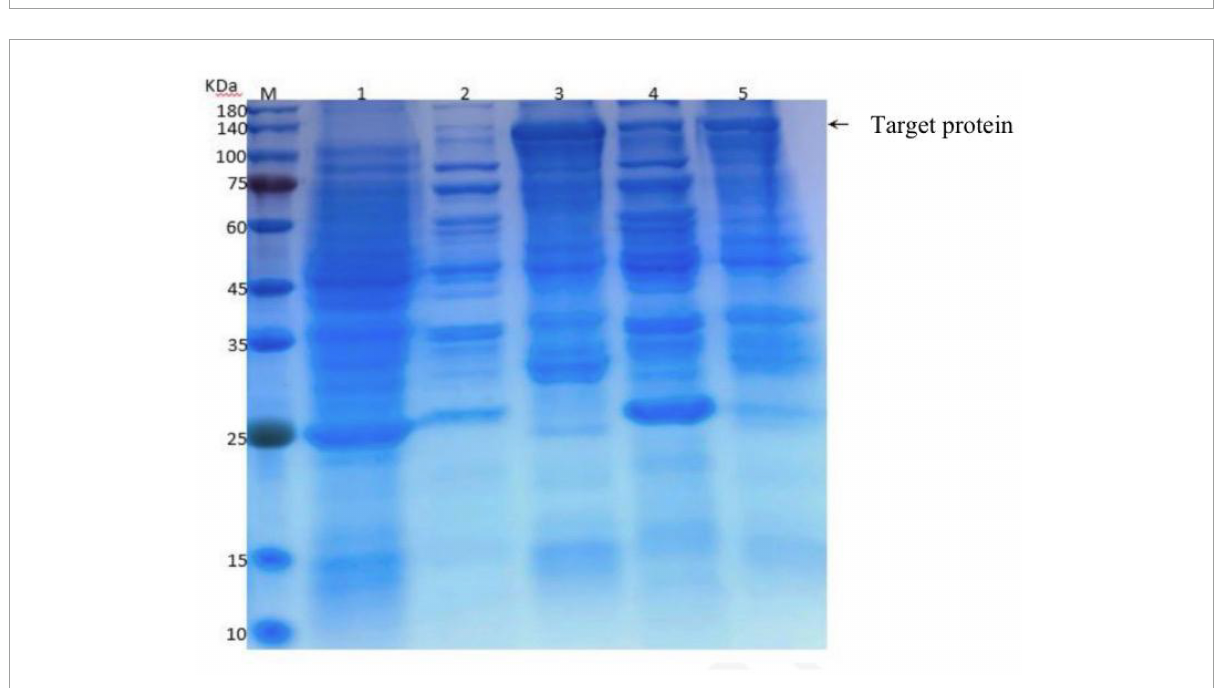
FIGURE7 Induced expression of the recombinant plasmid at different temperatures. M: Protein marker; 1: Total protein before induction; 2–5: BL21-pET-DN676-induced supernatants at 20 ◦ C, precipitates at 20 ◦ C, supernatants at 37 ◦ C, and precipitates at 37 ◦ C.